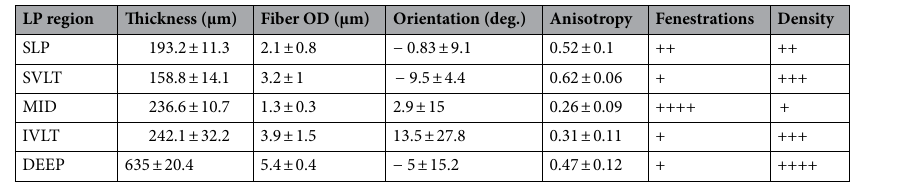
Table 1. Quantitative morphometric evaluation of the human vocal fold collagen distribution using SHG imaging.